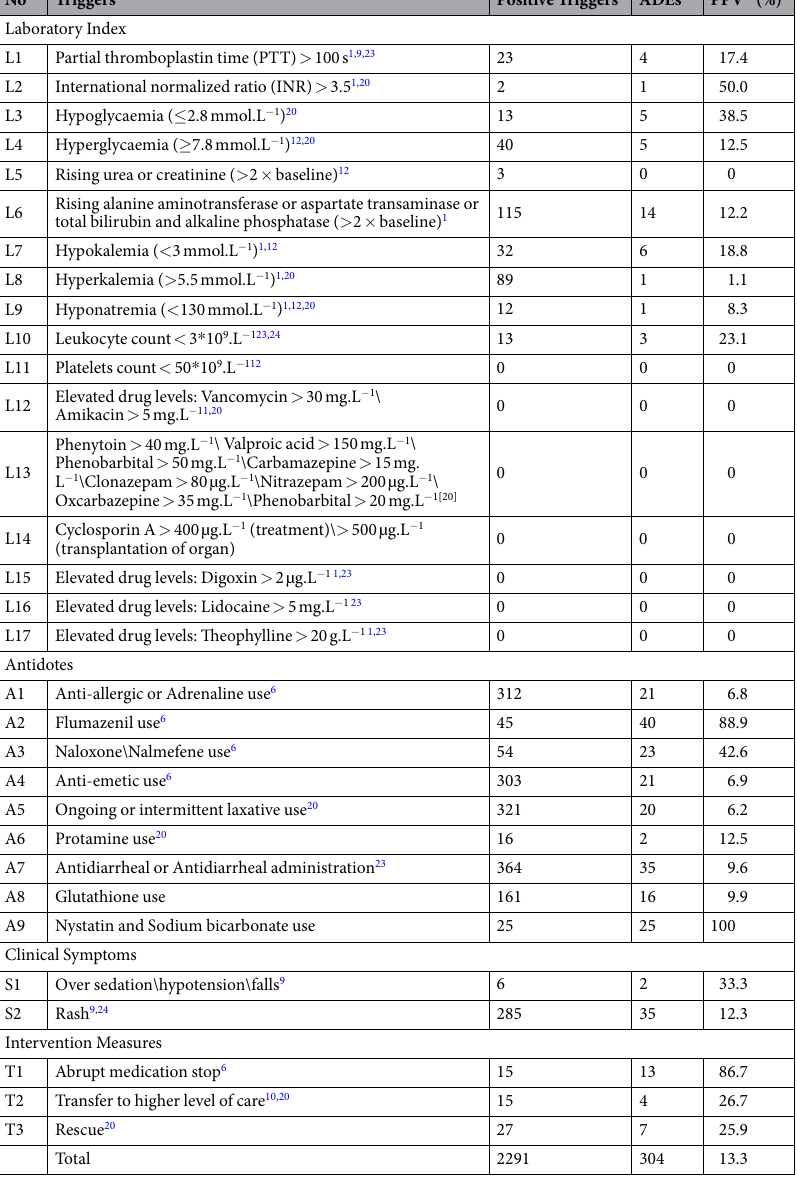
Table 2. The Trigger Items of CHCMU and its PPV. † ADEs, Adverse drug events; it indicates the number of adverse drug events detected by triggers, and different triggers in a patient can indicate same adverse drug events. ‡ PPV, Positive predictive value; it indicates the percentage of triggers that predict